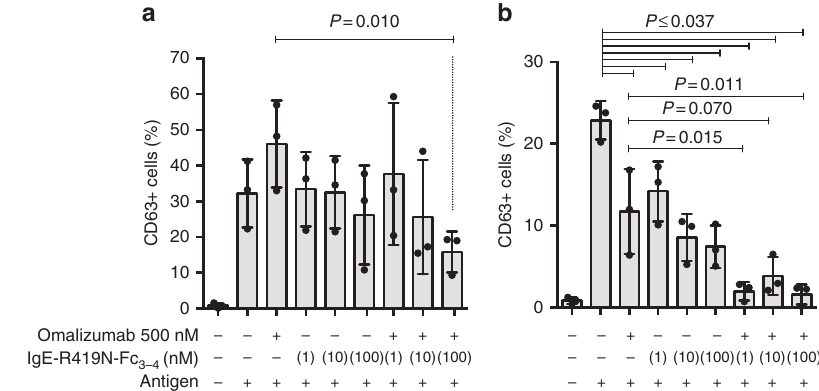
Figure 7 | IgE-R419N-Fc 3-4 and omalizumab act synergistically. Human basophils from three healthy volunteers were isolated, stripped of native IgE by bi53_79 DARPin treatment and reloaded with NP-reactive JW8-IgE. These NP-reactive basophils were then cultured with or without omalizumab and IgE-R419N-Fc 3-4 as indicated for 3 ( a ) or 6 ( b ) days before antigen challenge. Basophil activation was assessed by the per cent of CD63-positive cells. There was a statistically significant difference between groups as determined by a repeated-measures analysis of variance ( F ¼ 7.4, P ¼ 0.0004 Day 3 and F ¼ 19.3, P ¼ 0.0001 Day 6), and a Tukey post hoc test was used to determine the significance of differences between groups. On day 6, the untreated basophils showed reduced activation, which likely reflects the spontaneous loss of